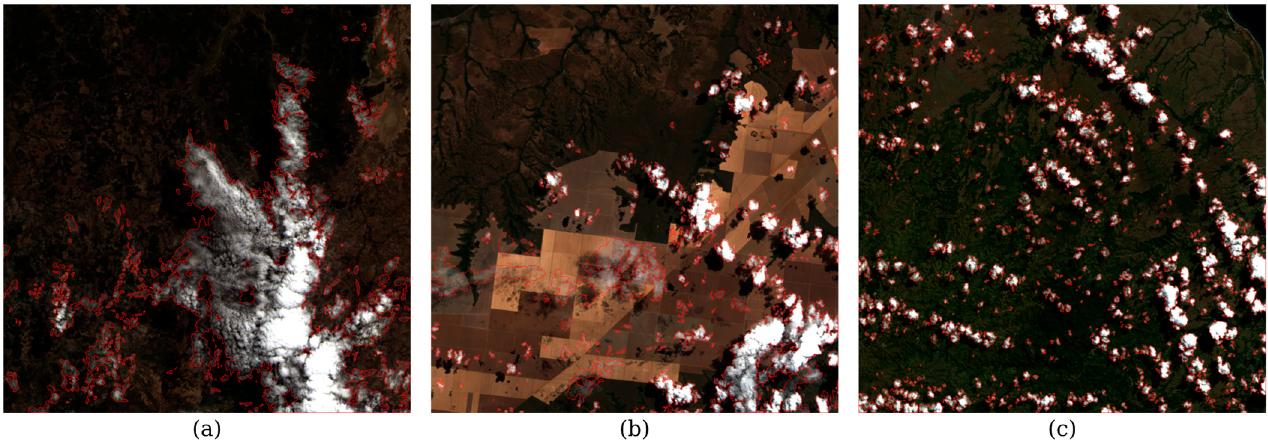
Figure 1. A highly blended scene with thick and thin clouds of di ff erent scale sizes and fragmenta- tion (cloud boundaries are marked by red lines). ( a ) indistinguishable cloud boundaries, ( b ) thin clouds, ( c ) various scales of fi nely-broken clouds.